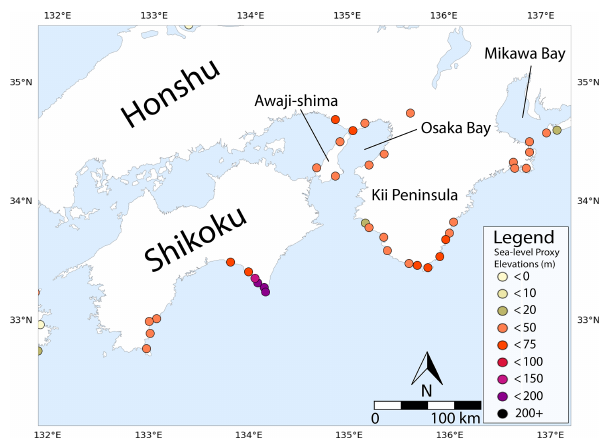
Figure 8. Sea-level elevation proxies in Shikoku and the Kii Penin- sula. Sea-level indicators (circles) with elevation range indicated by color (see